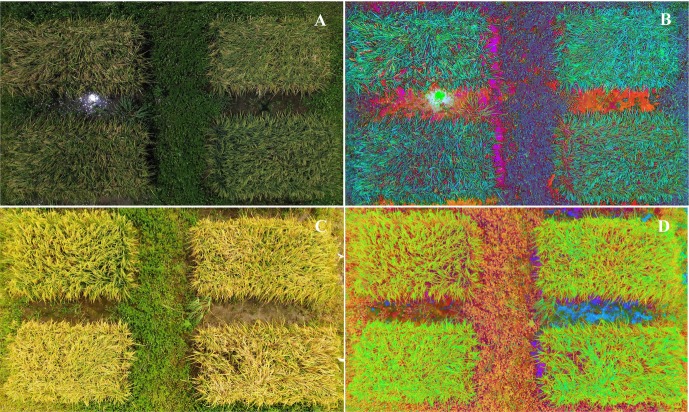
RGB and HLS images at 5.5-m flying altitude on Aug 23rd (A and C) and Aug 30th (B and D).